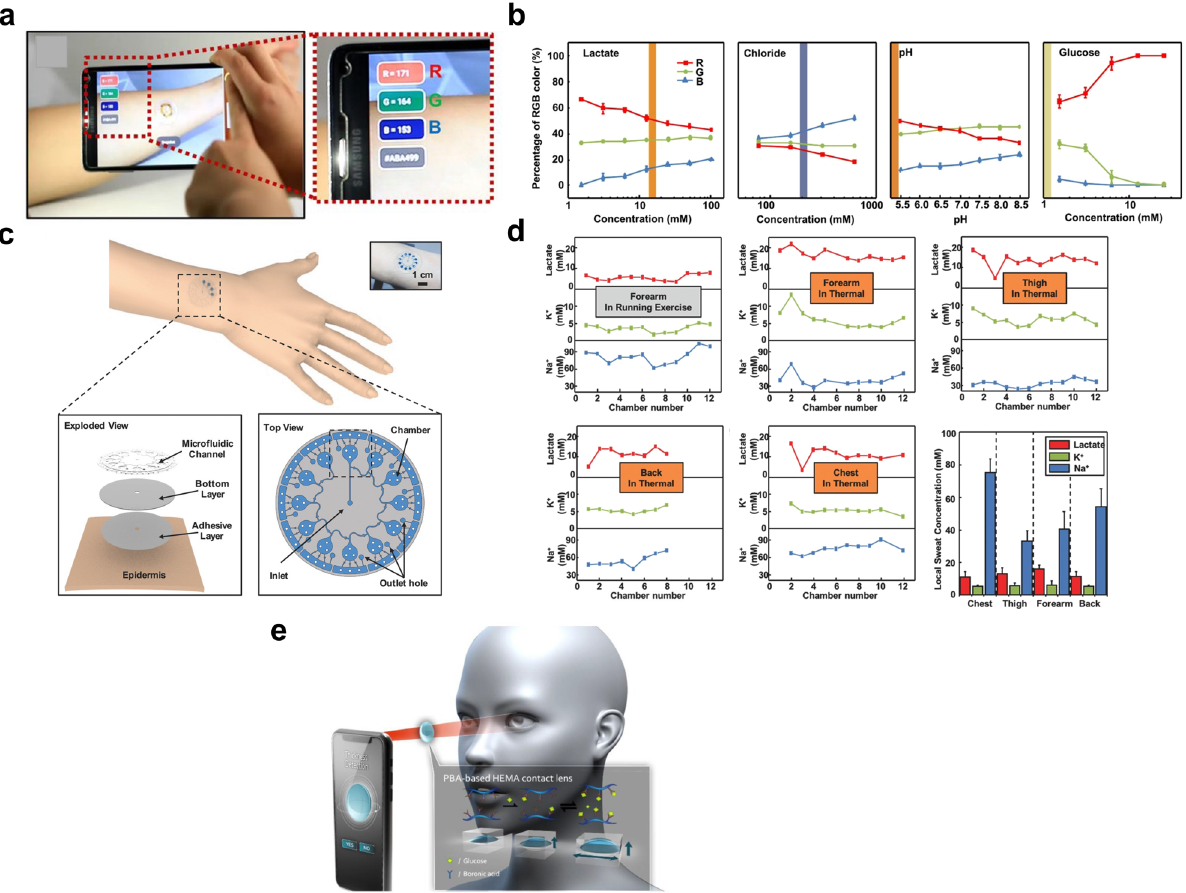
Fig. 5 Bio fl uidic-based HWDs. a Colorimetric analysis of sweat from the image captured using smartphone. b Quanti fi cation of the concentration of chloride, hydronium ions, and glucose and lactate levels using HWD as illustrated in a . Reproduced with permission from